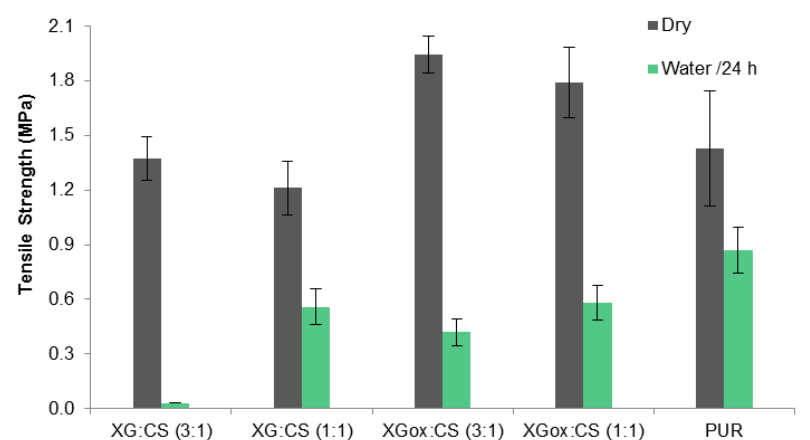
Figure 6. Tensile strength and water resistance of cork joints glued with xanthan gum–chitosan and oxidized xanthan gum–chitosan glues (6% concentration). Error bars represent standard deviations for a minimum of five measurements.